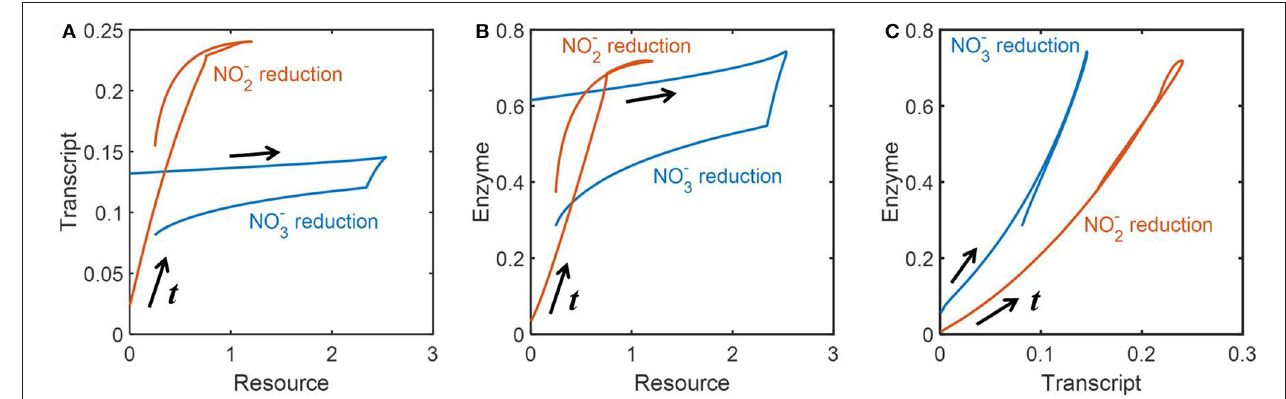
FIGURE 6 | Phase diagrams of resources, transcripts and enzymes: the dynamic relationships (A) between the concentrations of resources and transcripts, (B) between the concentrations of resources and enzymes, and (C) between the concentrations of transcripts and enzymes. The time scales of all data are adjusted to remove the effect of time delay based on the quantification in Figure 5B